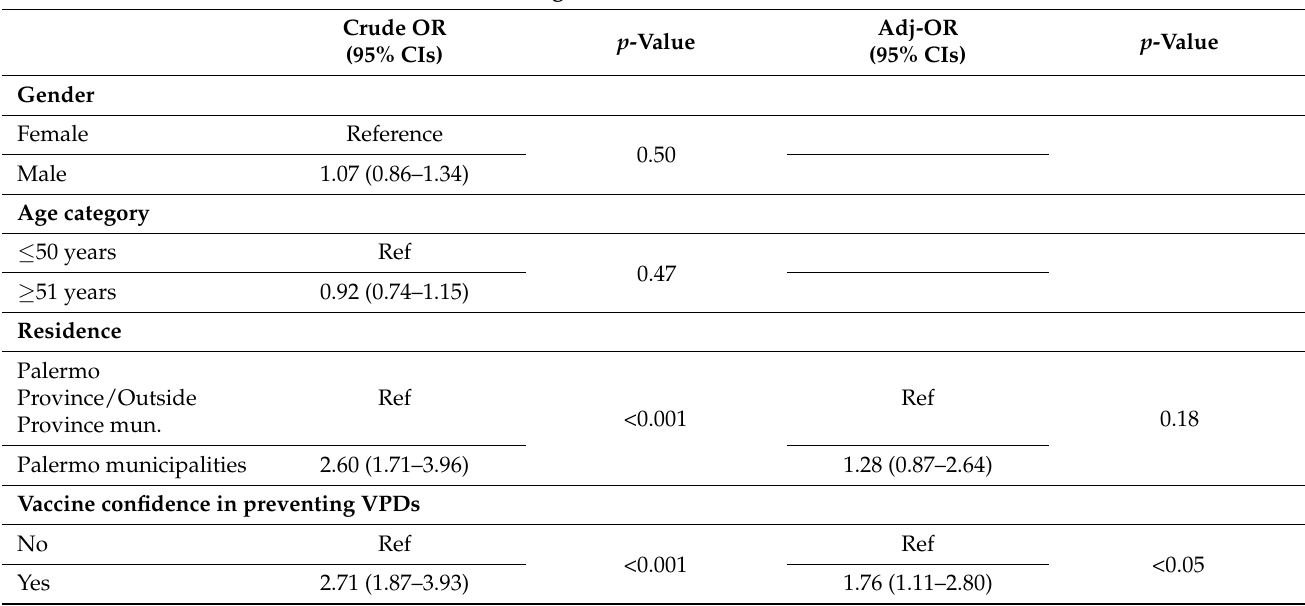
Table 4. Factors associated with willingness to receive COVID-19 vaccination in the univariable (crude OR) and multivariable (adj OR) analyses among study participants in the baseline survey ( n = 1450) (95% CI: 95%confidence